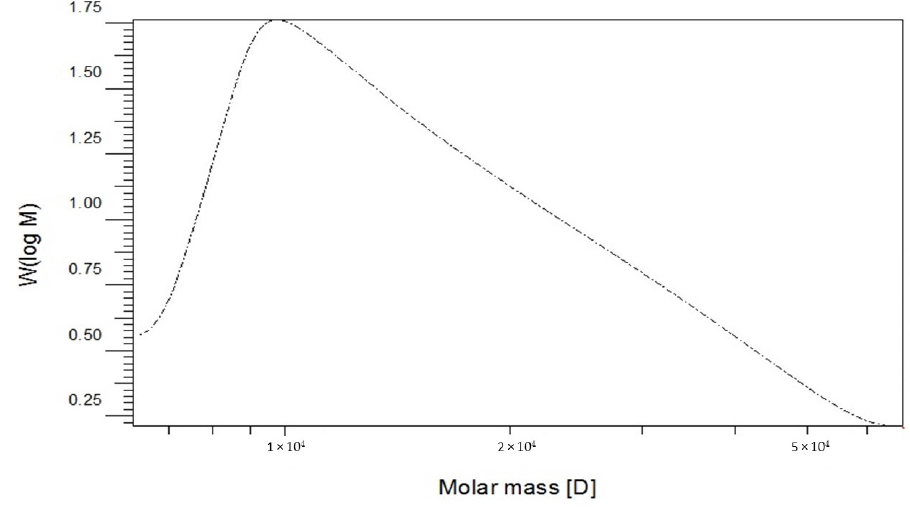
Figure 3. Gel permeation chromatography analysis of the semi-purified EPSR4 from R4 bacterium isolate.